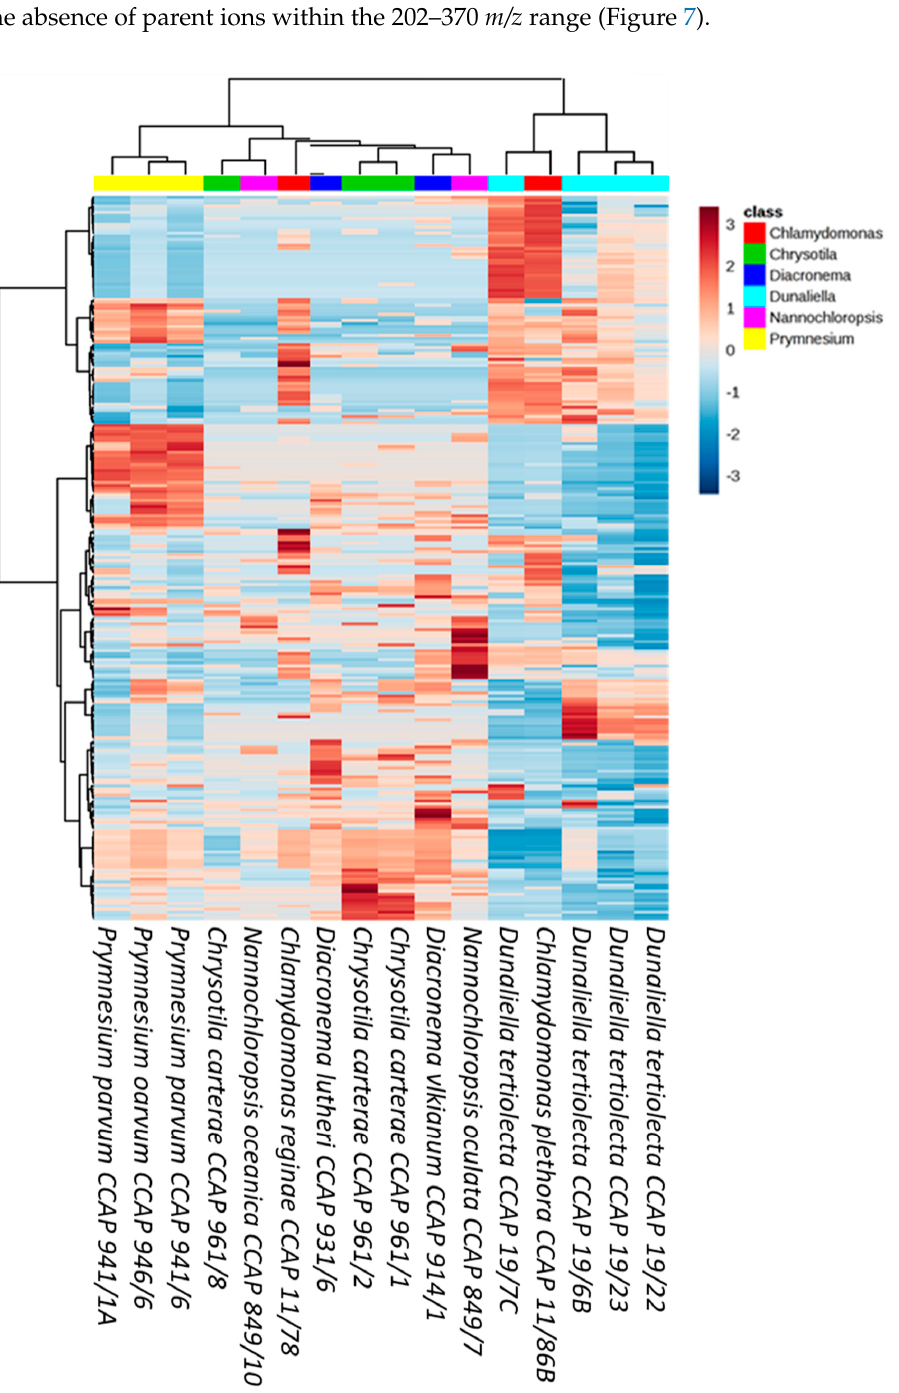
Figure 7. Hierarchical clustering of all detected ions across Prymnesium (yellow), Chlamydomonas (red), Chrysotila (green), Diacronema (dark blue), Dunaliella (light blue), and Nannochloropsis (pink). Heatmap shows relative abundance (low; blue, high; red) of respective features.